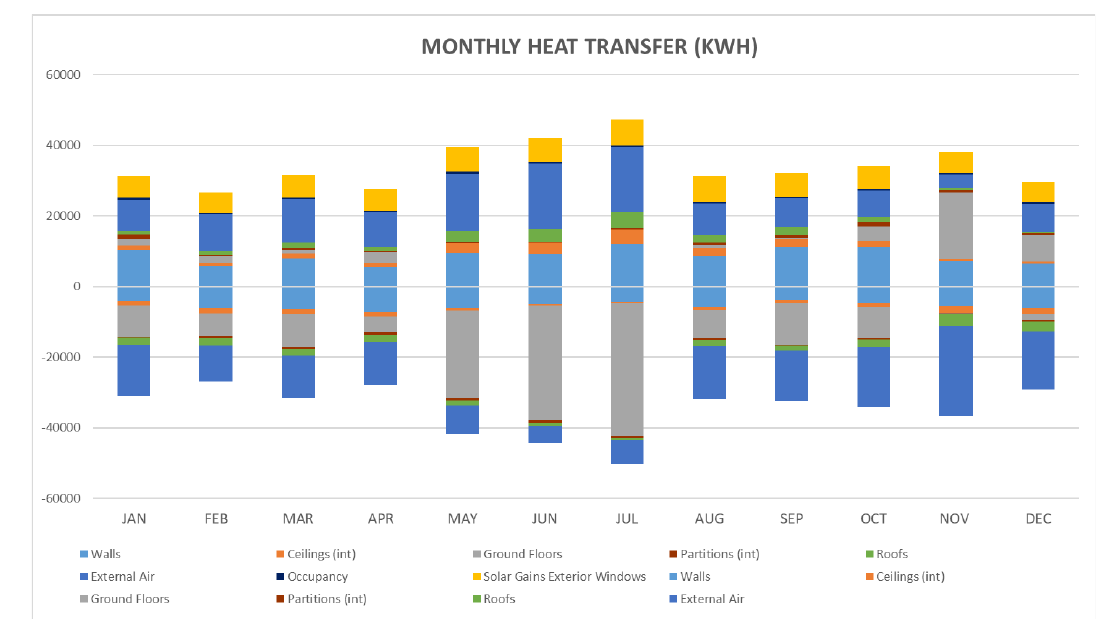
Figure 28. Monthly heat transfer in